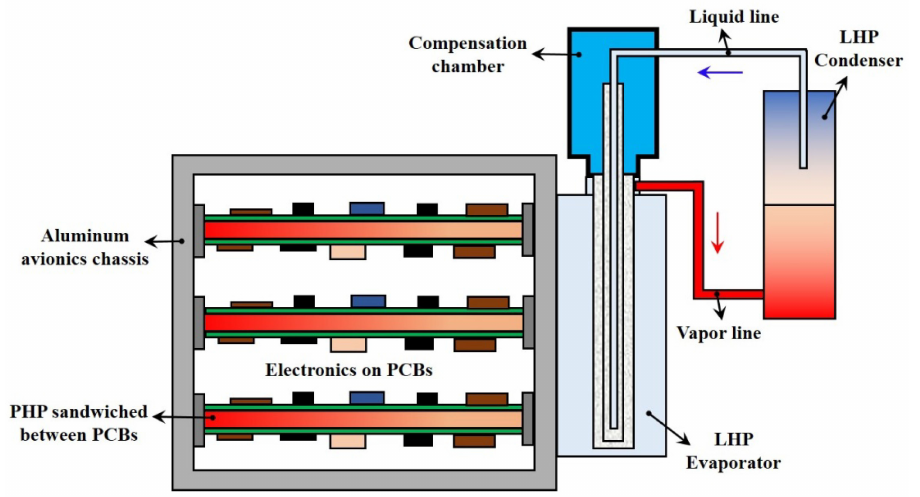
Figure 16. Schematic of the hybrid passive cooling system